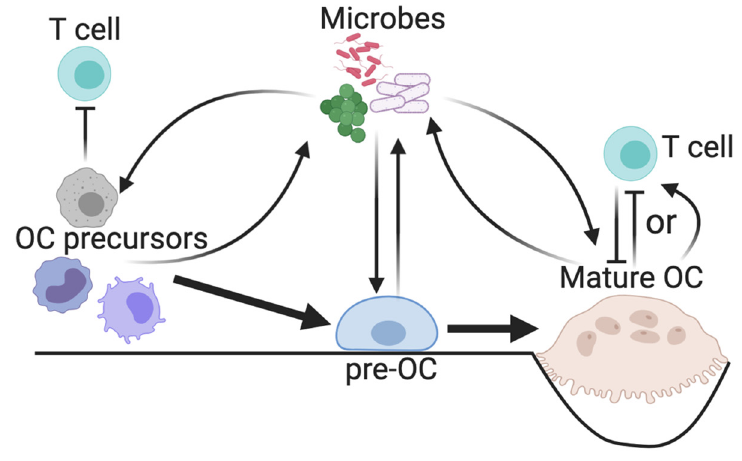
Figure 2. Relationship between microbes, OC lineage cells, and T cells. The presence of microbes in bone expands OC precursors, including the homeostatic monocytic precursors, those with myeloid-derived suppressor cell (MDSC) properties, and dendritic cells (DCs). Both MDSC-type OC precursors and mature OCs can inhibit pro-inflammatory T cell functions, whereas DC-derived OCs have been shown to enhance T cell activation. Whether the primary OC effect on T cells during infection is mainly inhibitory or pro-inflammatory has not yet been definitively demonstrated.